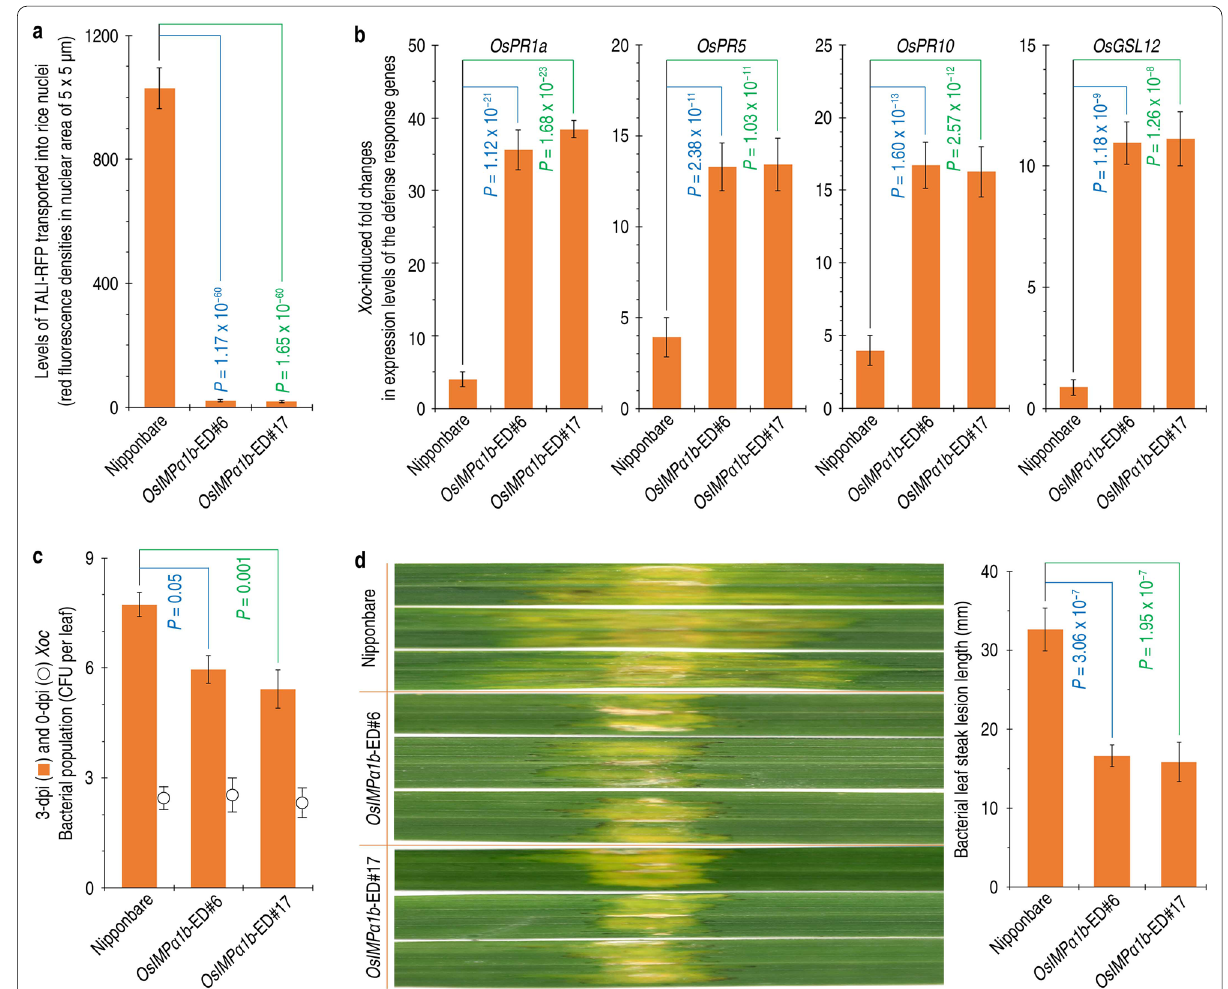
Fig. 7 Effects of TALI translocation into the nuclei of rice cells on the expression of genes involved in the rice defense response and Xoc virulence. TALI localization to rice cell nuclei at 9 h post-inoculation (hpi) ( a ), expression of rice defense response genes at 24 hpi ( b ), in planta bacterial populations at 0 and 72 hpi ( c ), and disease severity at 10 days post-inoculation (dpi) ( d ) were determined. The data shown are mean values ( n 3). The P values are from two-sided unpaired Student’s t tests ( P < 0.01). In d , the leaf images are representative of 30 leaves of 15 plants tested = in 3 experimental replications per genotype (WT, OsIMPα1b -ED#6, or OsIMPα1b